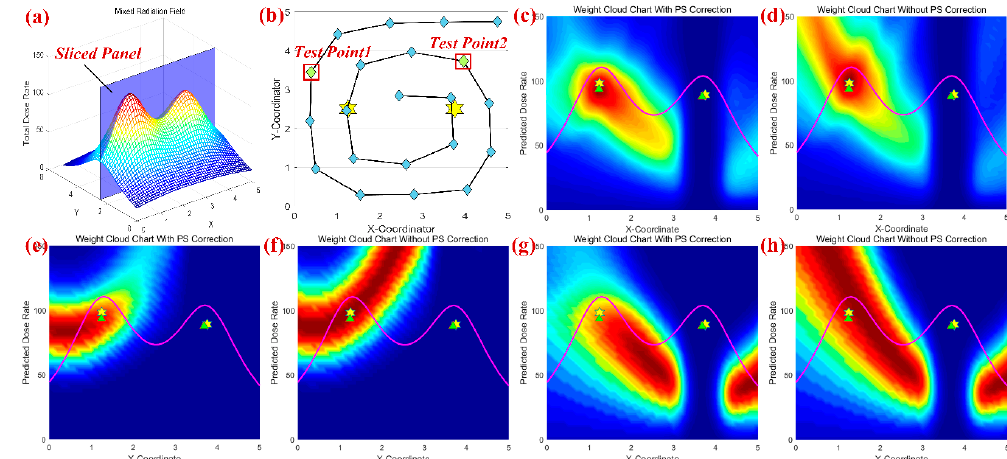
Figure 5. The functional specifications of peak suppressed module. ( a , b ) indicates the positions of measurements and sources, and the radiation distribution. ( c , d ) shows the overall weight distributions in sliced panel for corrected and non-corrected case. ( e – h ) shows the weight distributions for one measurement (point1 & point2) in corrected and non-corrected cases.